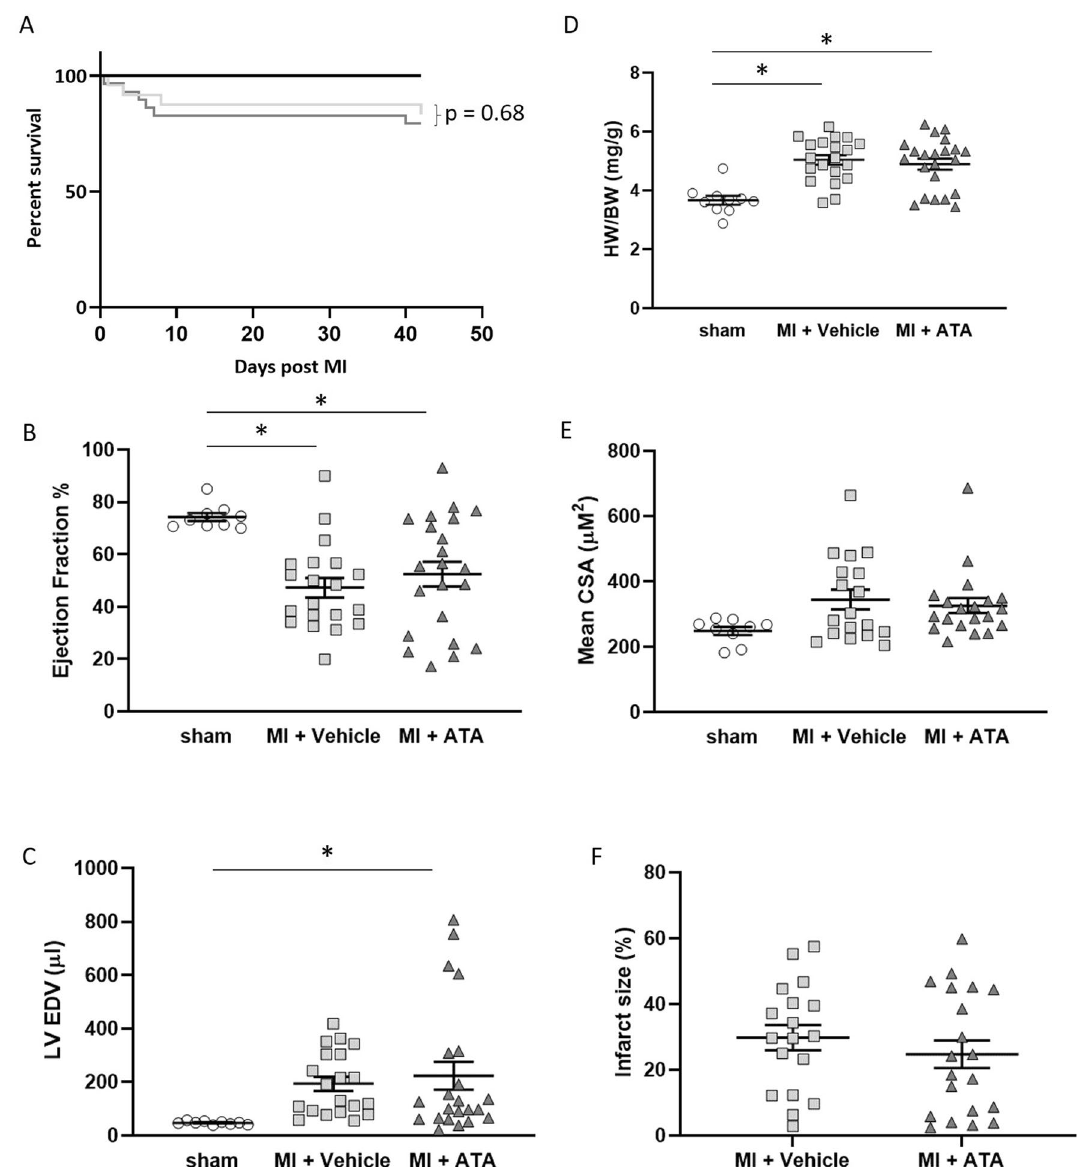
Figure 9. Treatment with PMCA 4 specific inhibitor does not affect cardiac structure or function post-MI. ( A ) Kaplan–Meier survival plots for mice subjected to sham surgery (black), or left anterior descending coronary artery ligation with vehicle (light grey) or PMCA4 inhibitor ATA treatment (dark grey) followed for 6 weeks post MI. Starting populations: sham n = 10, MI + vehicle n = 24, MI + ATA n = 29. ( B ) Left ventricular ejection fraction and ( C ) End diastolic volume 6 weeks post-MI or sham surgery as measured by echocardiography. ( D ) Heart weight/body weight ratio 6 weeks post-MI or sham surgery. ( E ) Mean myocyte cross sectional area 6 weeks post-MI or sham surgery. ( F ) Infarct size 6 weeks post MI. sham n = 10, MI + vehicle n = 20, MI + ATA n = 22 * p <